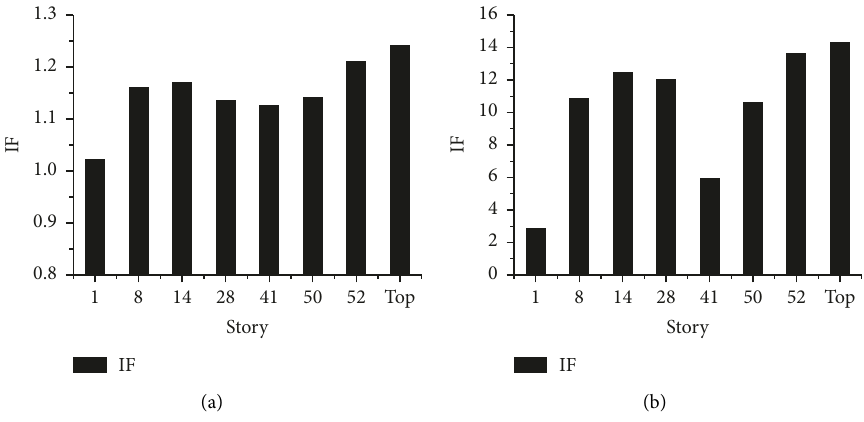
Figure 13: IF along stories: (a) Frequent 6; (b) Rare